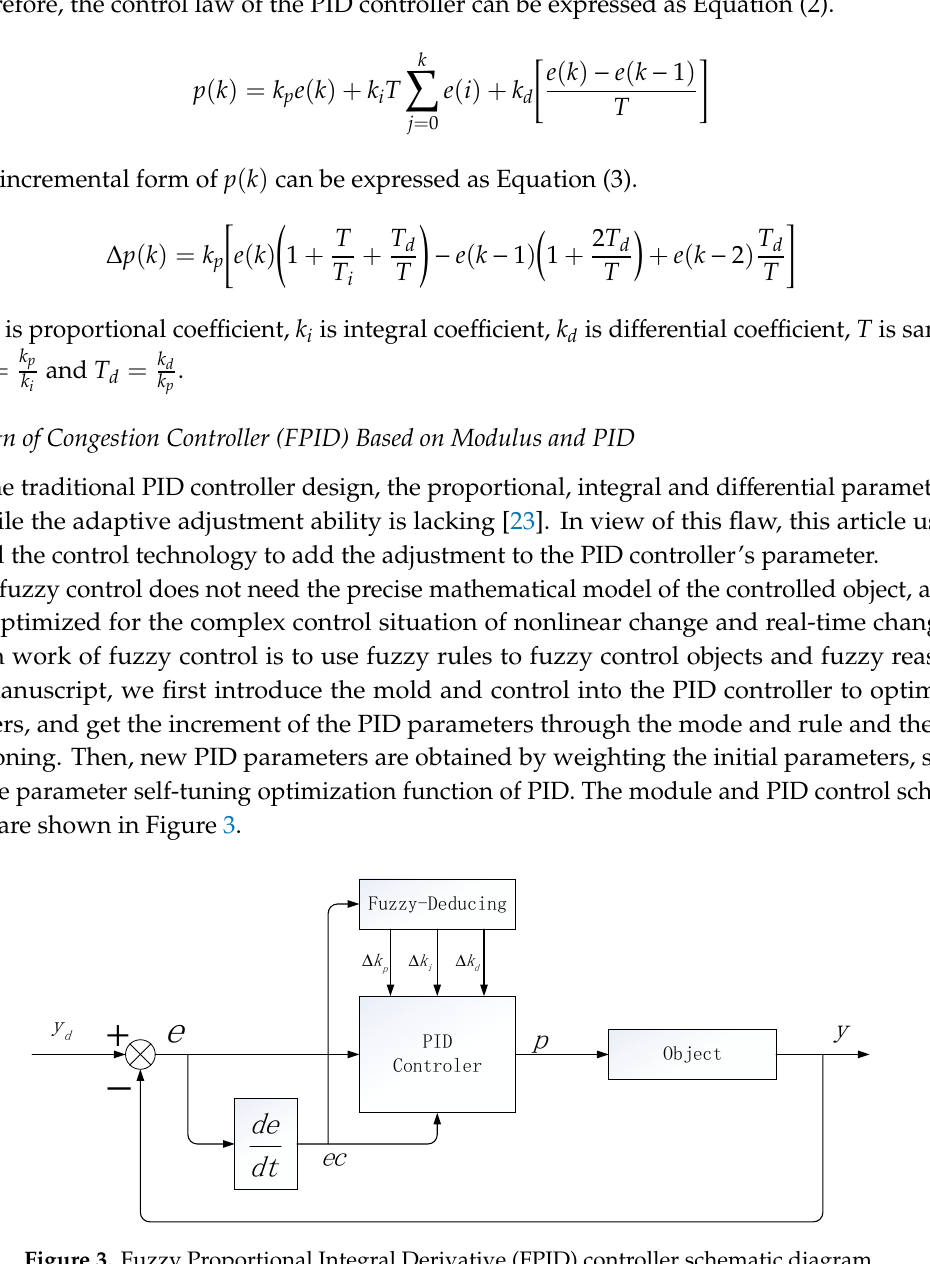
Figure 3. Fuzzy Proportional Integral Derivative (FPID) controller schematic diagram.